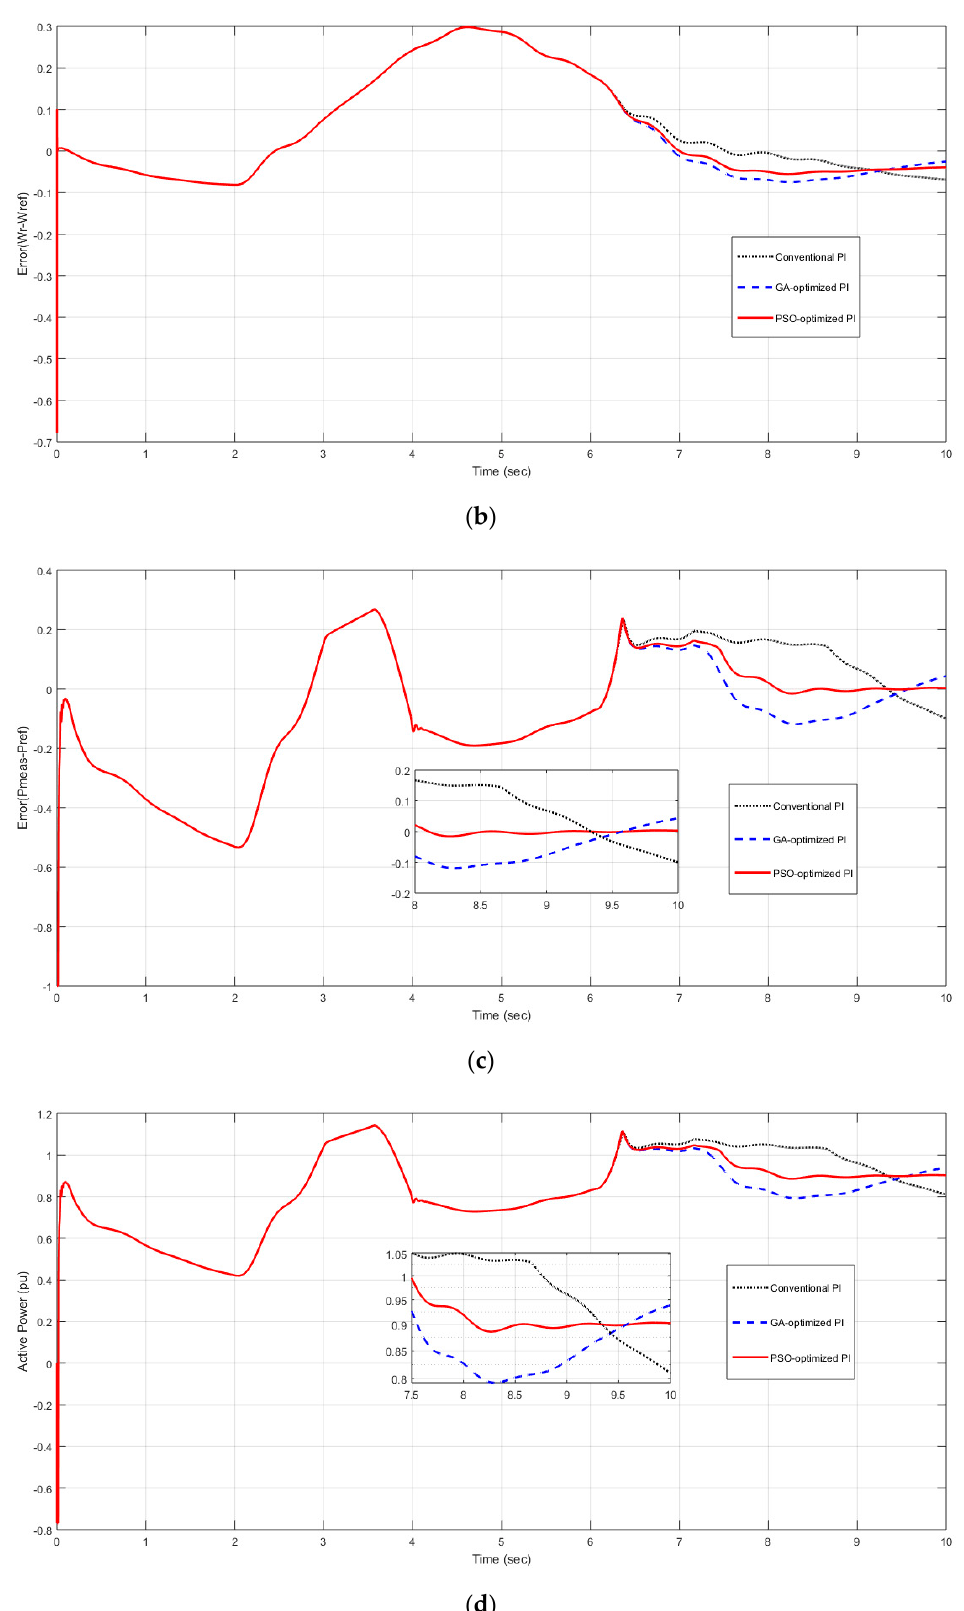
Figure 9. System response in Case 3 ( a ) pitch angle in degrees; ( b ) change in generator speed; ( c ) change in active power; ( d ) output power.